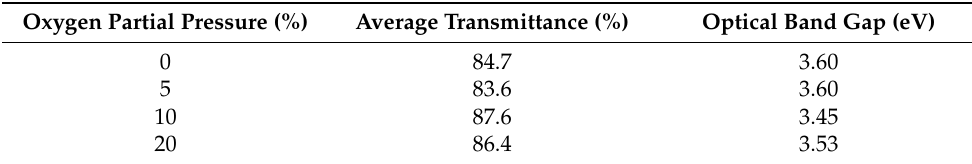
Table 1. Optical properties of praseodymium-doped indium-zinc-oxide (PrIZO) thin films with different oxygen partial pressures.